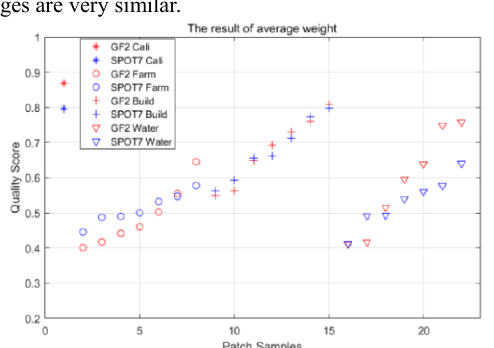
Figure 7. The evaluation results with average weight Secondly, we improved the weights of Nyquist and PSNR gradient, and suppressed the weights of edge intensity and average gradient. The weight is shown at table 4, No.2. The result is shown in figure 8. As we can see, with the weights biased towards PSNR and MTF, almost all kinds of patches’ quality of SPOT7 image is higher than GF2.